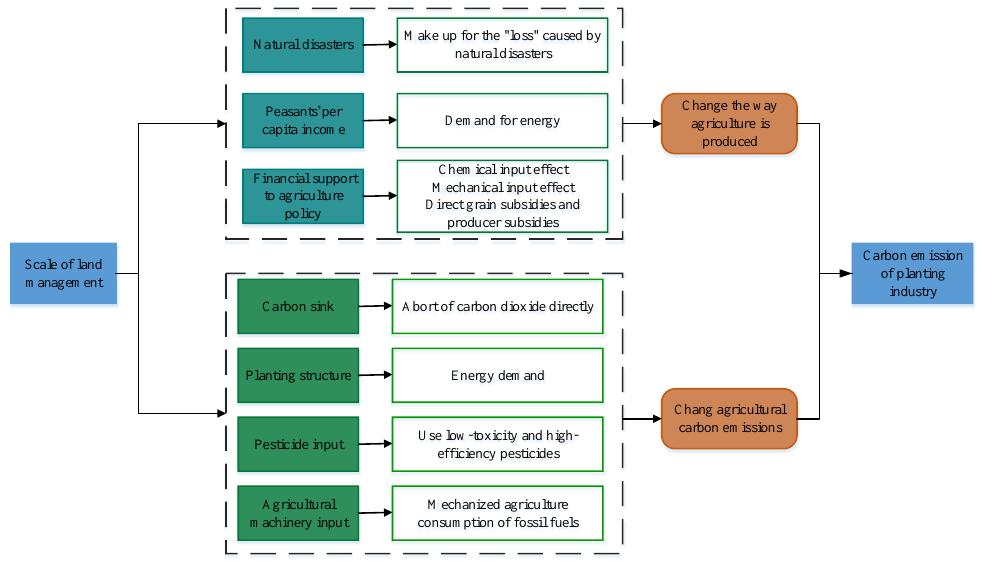
Figure 1. The mechanisms of the scale of land management on the carbon emissions of the planting industry.